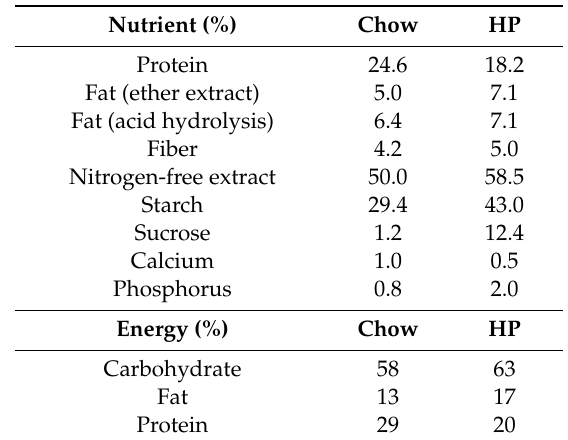
Table 1. Nutritional composition of the chow diet and the high phosphorus (HP)